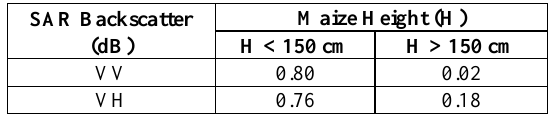
Table 3. Coefficient of determination (R2) between in-situ measured corn height and Sentinel-1 backscattering